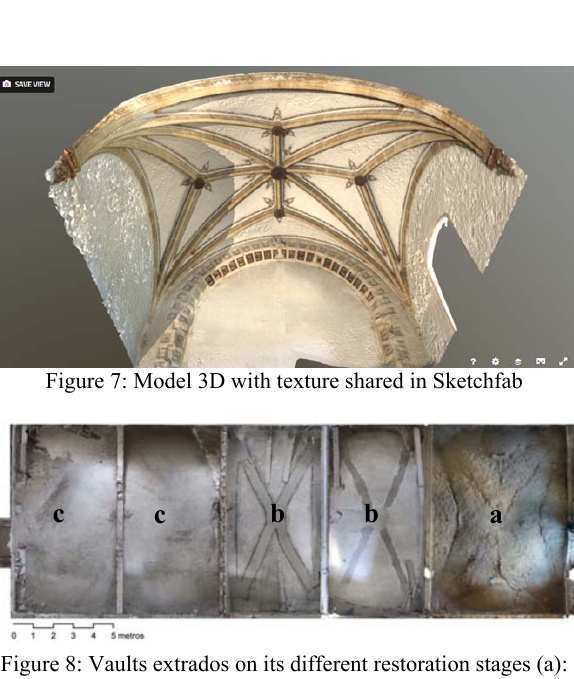
Figure 8: Vaults extrados on its different restoration stages (a): original, (b): during restoration, (c) finished. Photogammetric